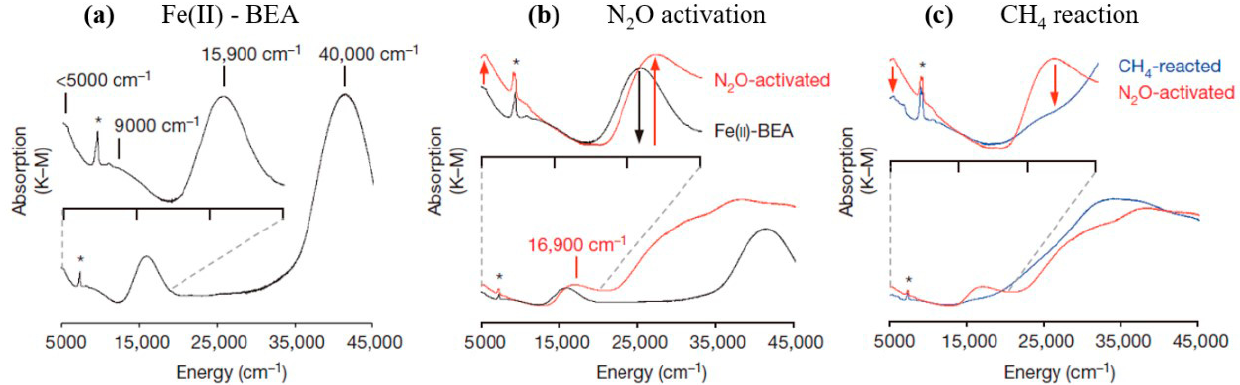
Figure 4. DR-UV–Vis spectra of Fe/BEA: ( a ) Before activation, ( b ) after N 2 O activation at 250 ◦ C, and ( c ) after reaction with CH 4 at room temperature. Adapted with permission from ref [46]. Copyright 2016